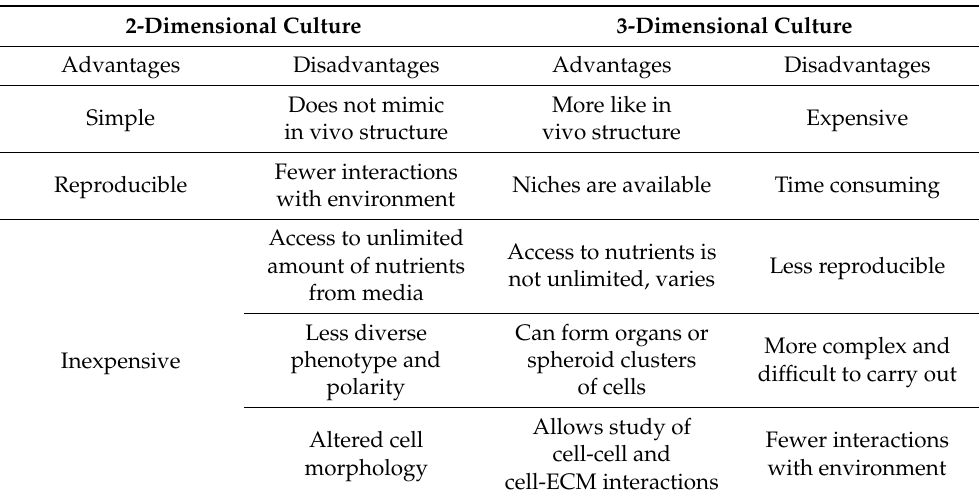
Table 2. 2D versus 3D cultures